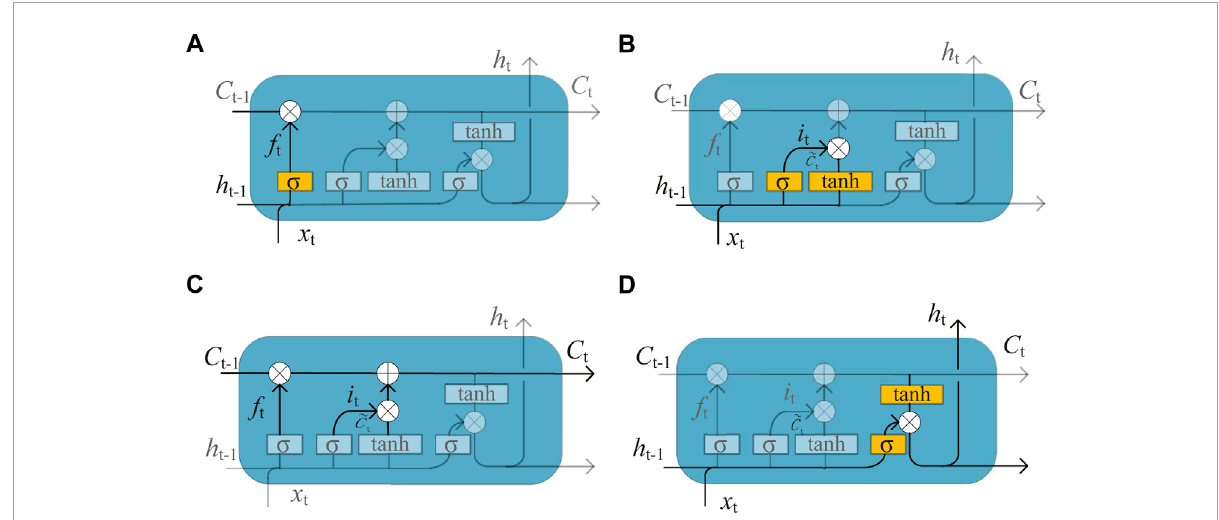
FIGURE 4 Structure of a cell in the LSTM neural network. (A) Forgetting gate. (B) Input gate. (C) State updating part. (D) Output gate.